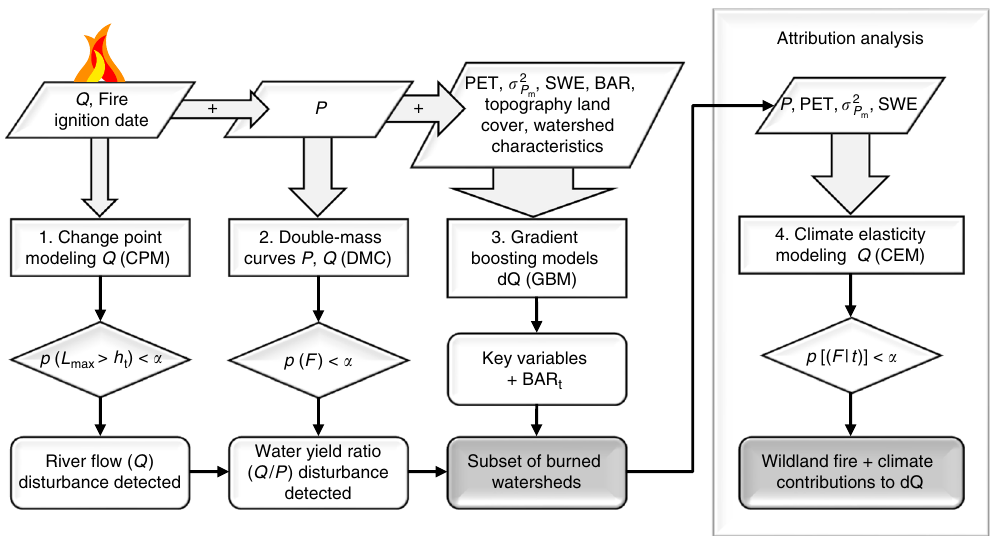
: monthly precipitation variance, SWE: snow m